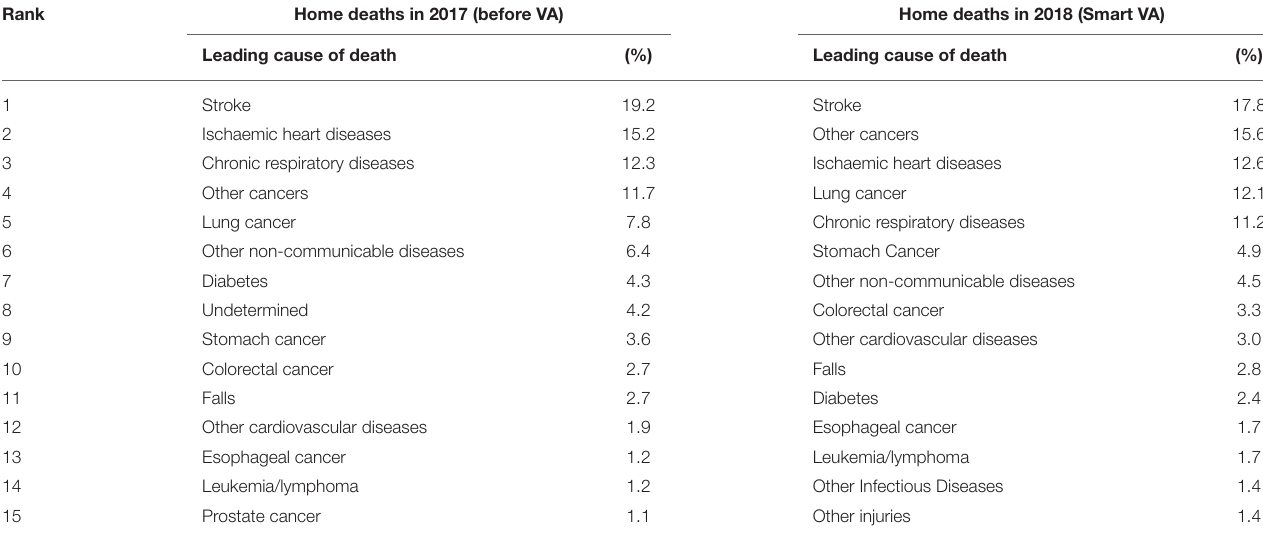
TABLE 2 | The cause-specific mortality fractions (CSMFs) of home deaths in the 16 regions of Shanghai in 2017 and in 2018. Rank Home deaths in 2017 (before VA) Home deaths in 2018 (Smart